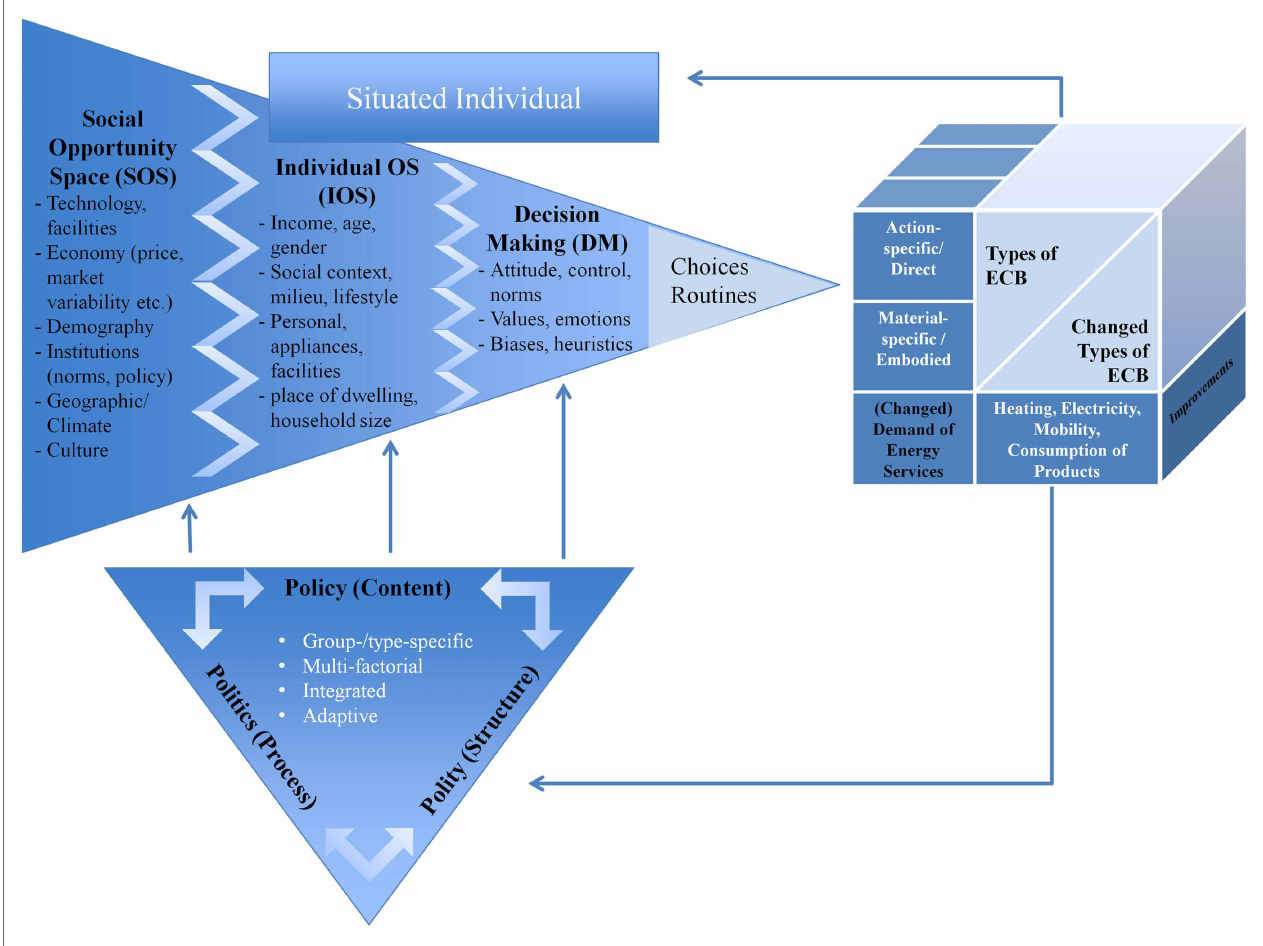
FiGUre 6 | integrated framework – understanding eCB and the governance of its change